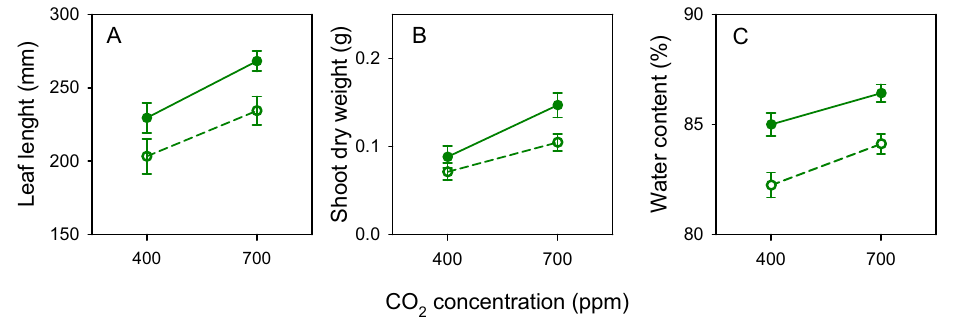
Figure 1. Effects of nitrogen (high: closed symbol, low: open symbol) and [CO 2 ] on the ( A ) length of the third leaf of wheat plants at 21 DAS, and ( B ) shoot dry weight and ( C ) shoot water content at 28 DAS. Error bars are two standard errors of the